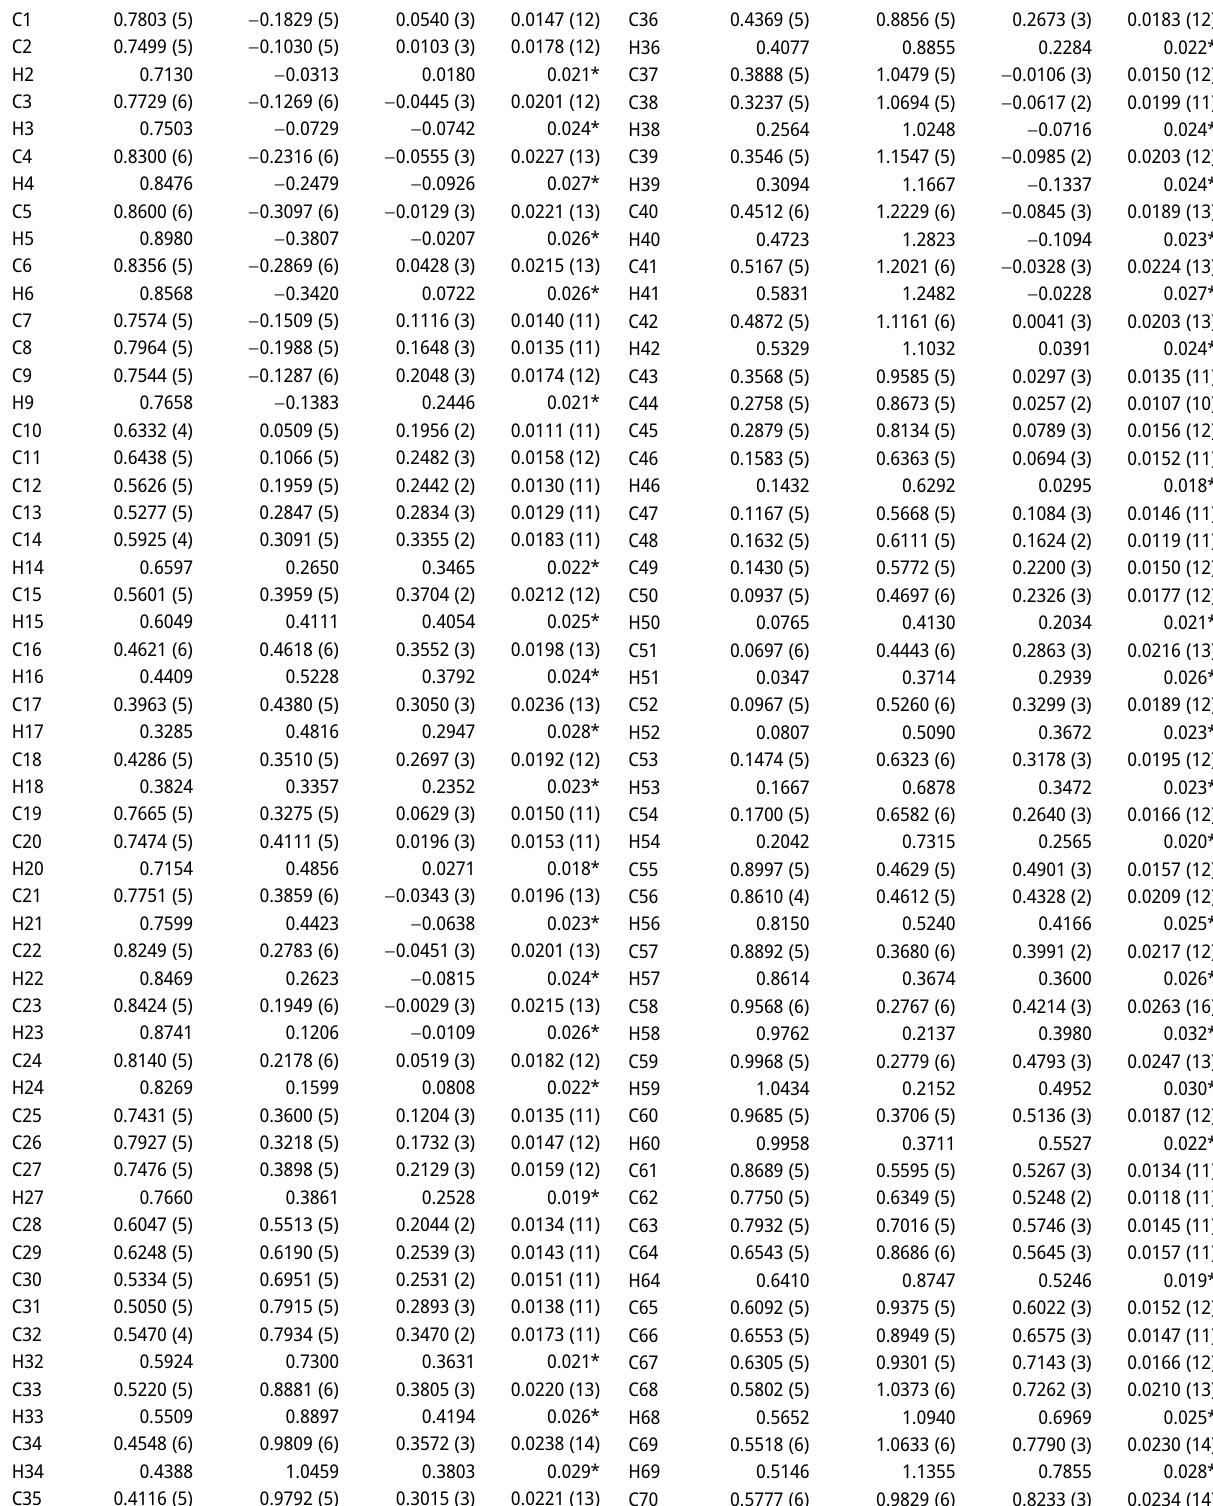
Table  : Fractional atomic coordinates and isotropic or equivalent isotropic displacement parameters (Å 